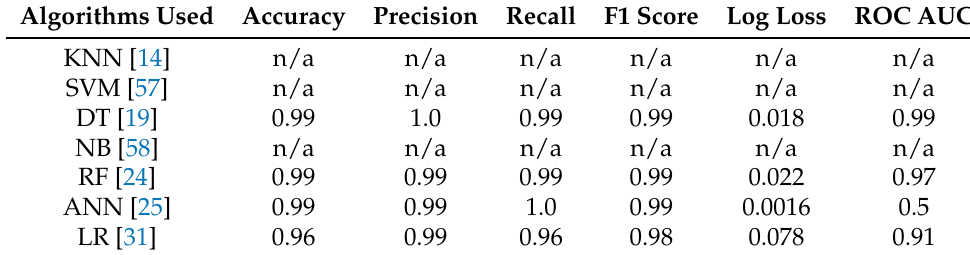
Table 36. DoS TCP weighted classes results.